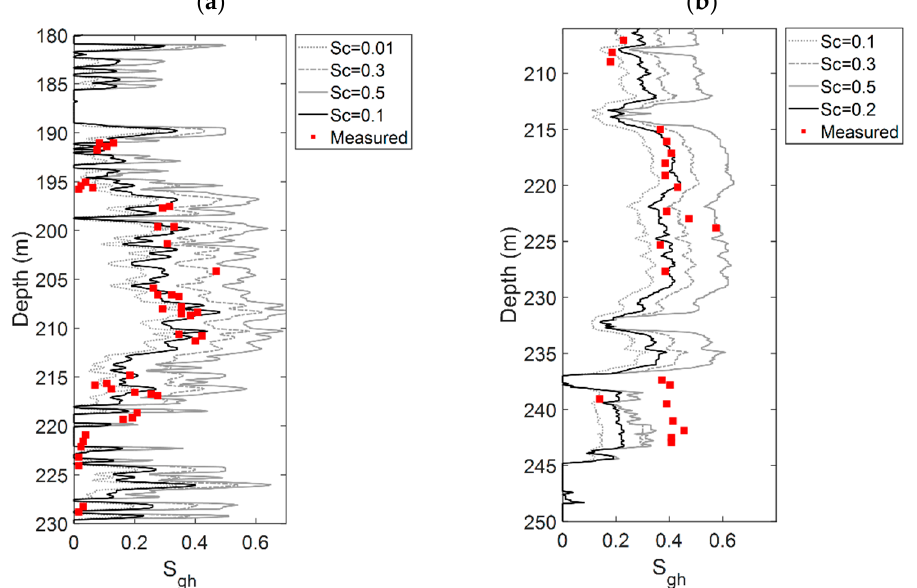
Figure 12. The estimated results of S gh for various S c values in ( a ) SH2 well, ( b ) SH17 well (note: the S gh data measured from the core samples is overlaid with solid-dotted markers).